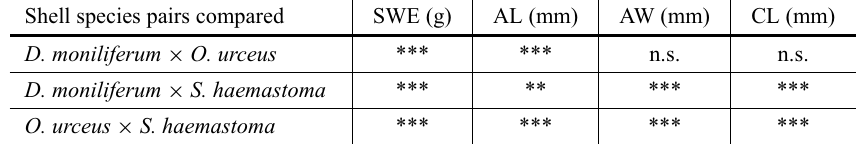
Clibanarius vittatus and shell species most often occupied by the hermit crabs. Dunn’s multiple comparisons test (P < 0.05) with significant differences in the comparison of morphometric variables between pairs of shell species and average CL of the hermit crabs that occupied these shells. Shell species pairs compared SWE (g)